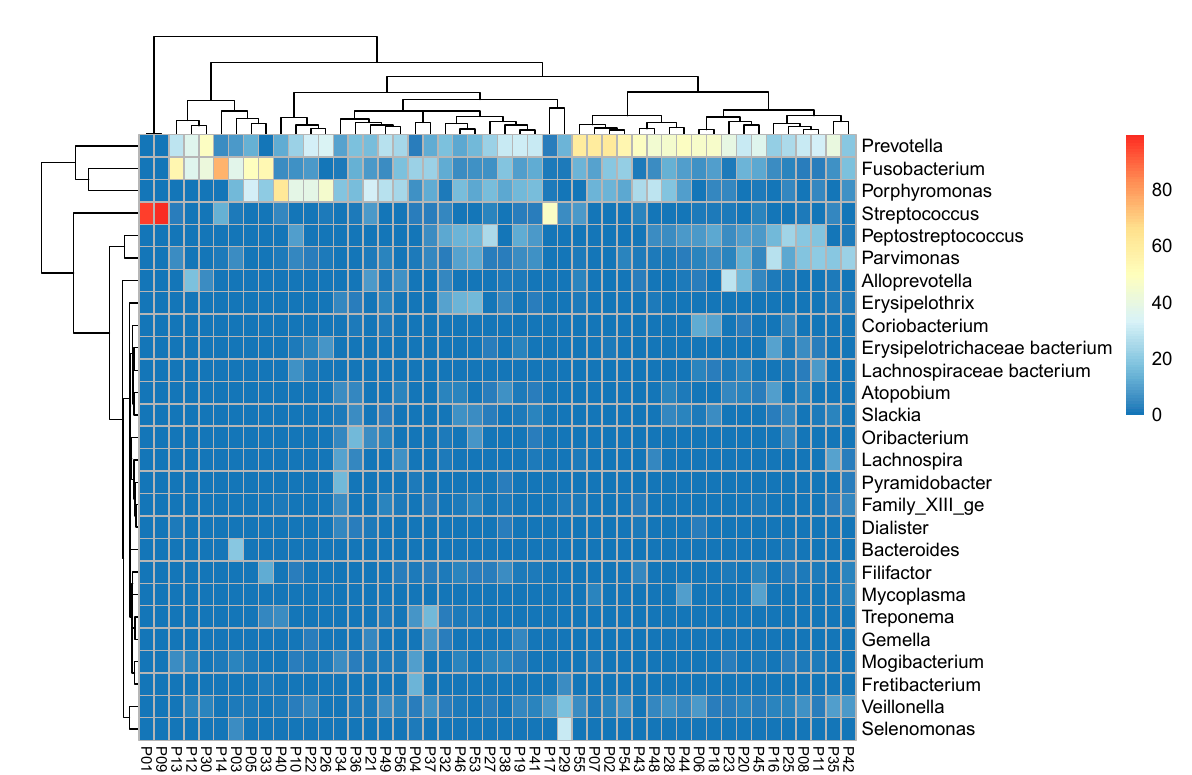
Table 1. 56 specifications of the culture analysis corresponded to a unique bacterial identification.